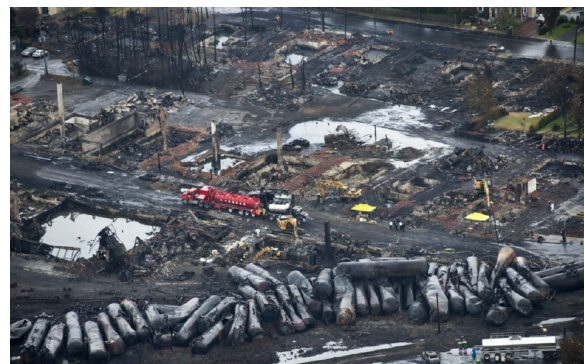
Figure 3. Consequences of freight train accident in Lac-Méganic, Quebec, Canada on July 6, 2013 [19].